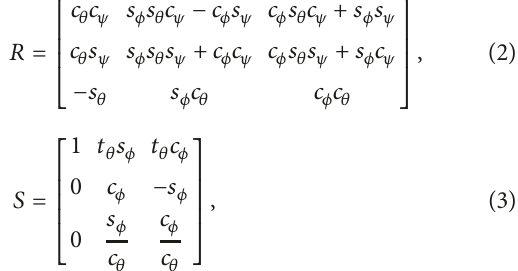
is the helicopter mass; 𝐼 = diag {𝐼 𝑋𝑋 , 𝐼 𝑌𝑌 , 𝐼 𝑍𝑍 } is the inertial moment matrix about the reference axes; 𝐹 𝑏 and 𝑀 𝑏 denote on the helicopter center of gravity (CG), respectively.